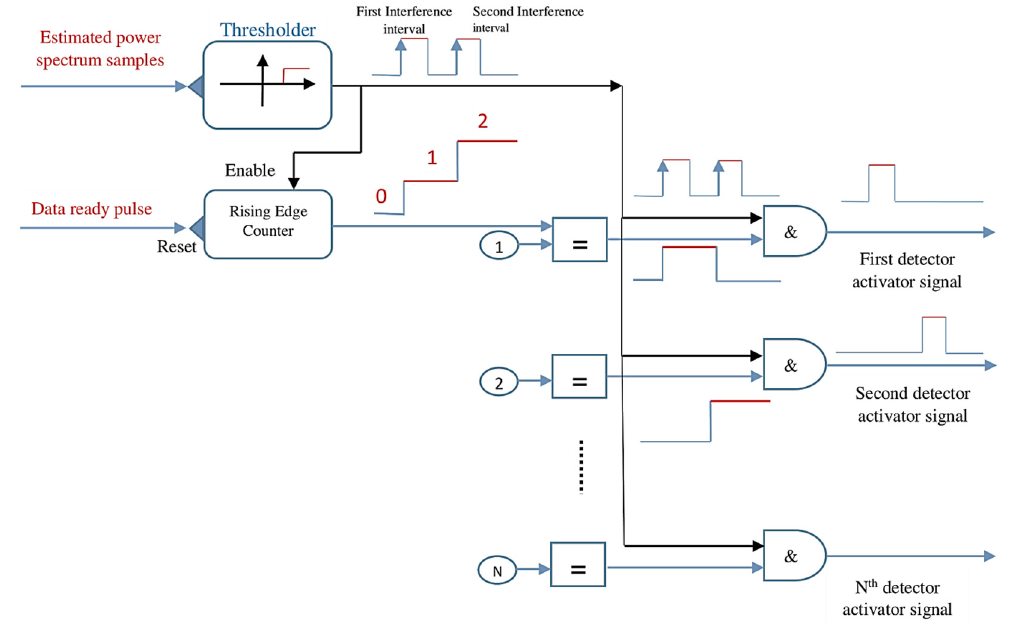
Figure 6. Utilized mechanism for activating each detector for an